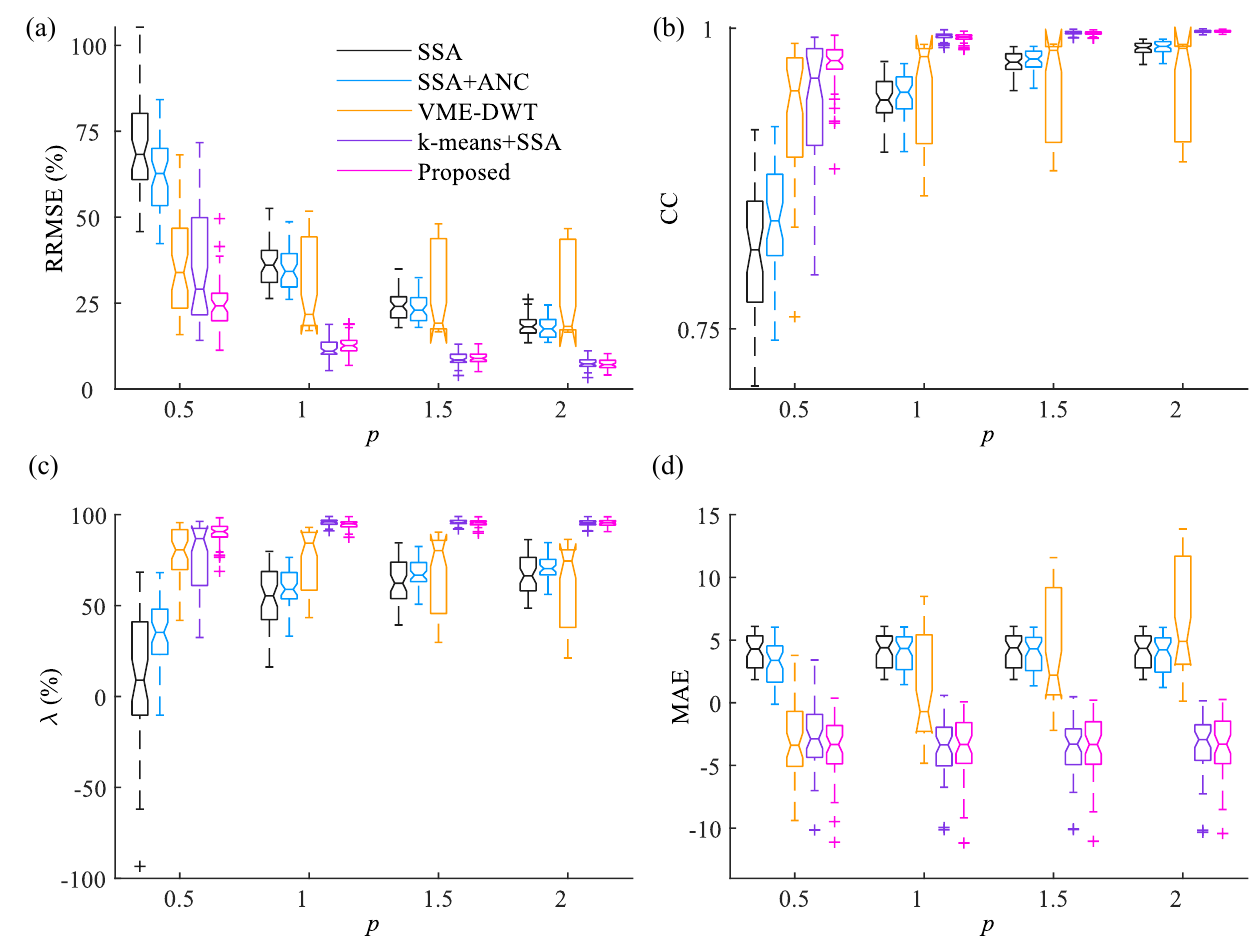
Figure 6. Performance of the existing and the proposed methods in terms of ( a ) RRMSE, ( b ) CC, ( c ) artifact removal ratio ( λ ) and ( d ) MAE (in log scale) with respect to the artifact mixing constant p . (The artifact mixing constant p is ∝ 1/ SNR ) of the